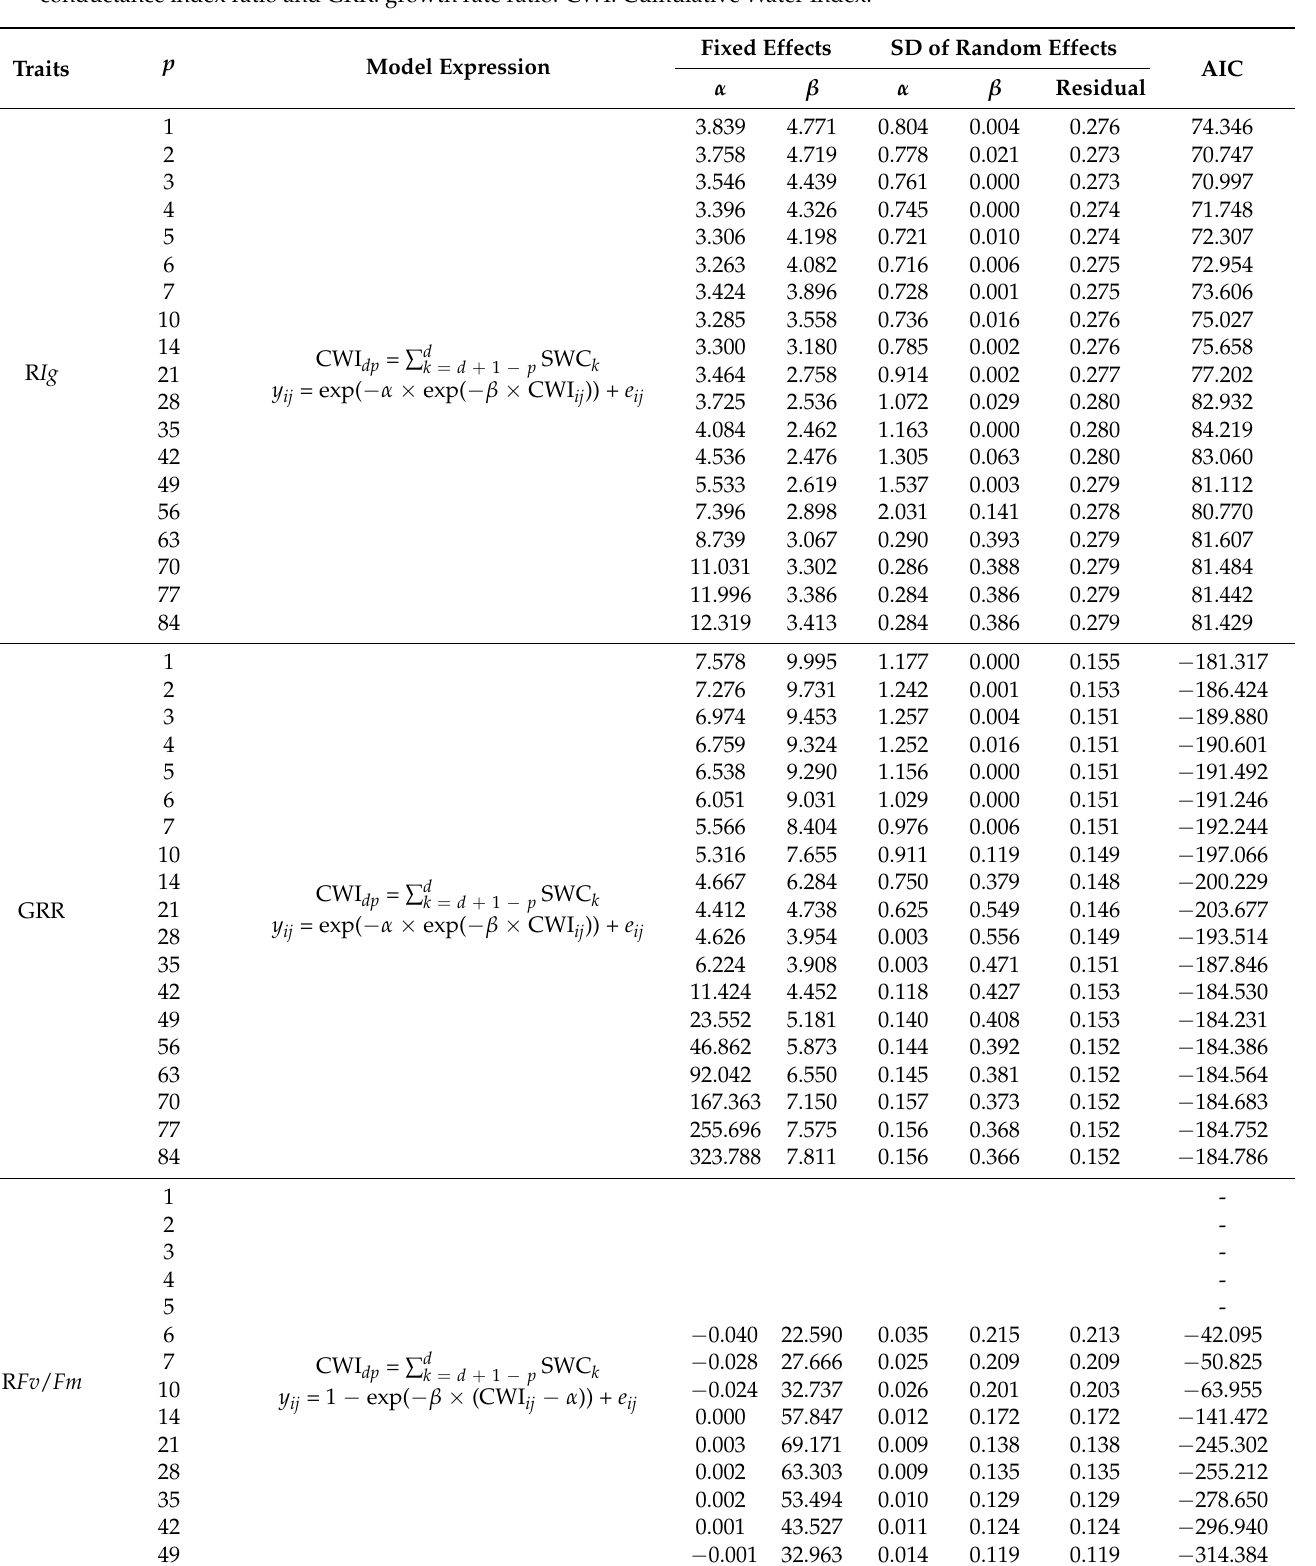
Table 2. Parameter estimates and Akaike’s information criteria (AIC) used in the models. For the maximum photochemical quantum yield of photosystem II (R Fv / Fm ), model algorism did not converge for p = 1, 2, 3, 4, and 5. R Ig : stomatal conductance index ratio and GRR: growth rate ratio. CWI: Cumulative Water